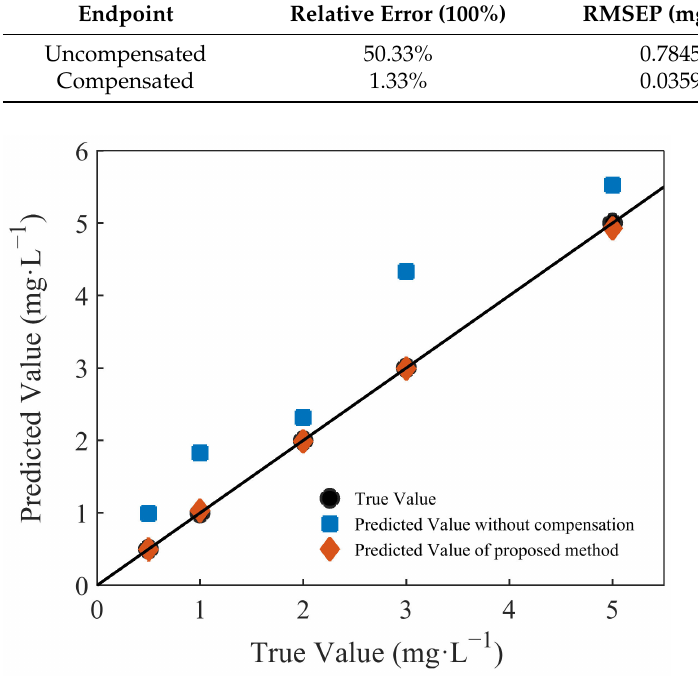
Figure 7. Comparison of the results of uncompensated and compensated